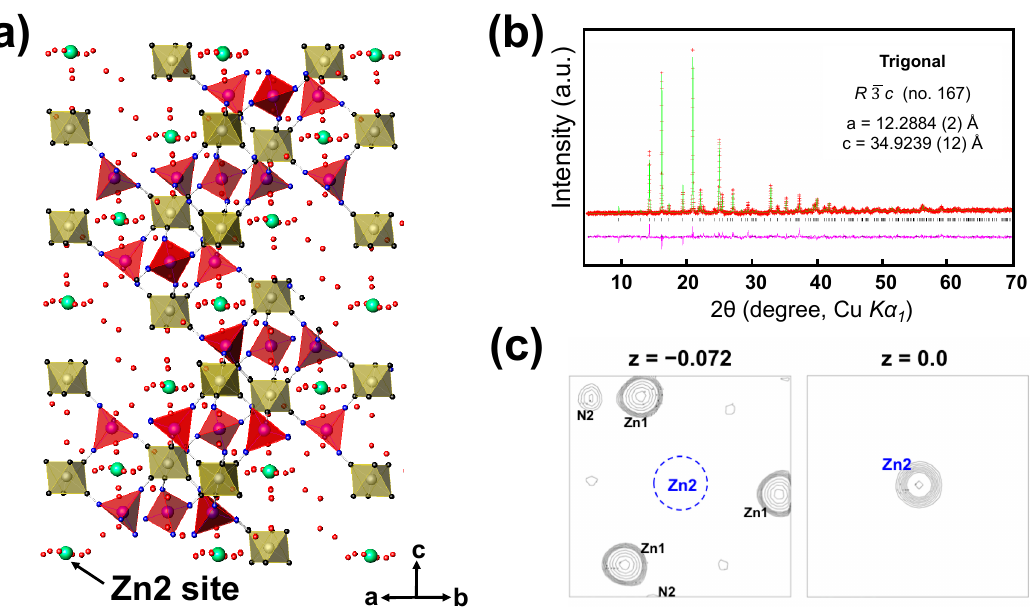
Figure 5. ( a ) The crystal structure of Zn 0.72 ZPB, with FeC 6 octahedra (yellow), ZnN 4 tetrahedra (red), and inserted Zn2 atoms (green). ( b ) The powder X-ray Rietveld refinement profile for Zn 0.72 ZPB, recorded at 25 °C (Red points: experimental data; green line: calculated data; pink line: difference; and bars: Bragg positions). ( c ) (001) sections of observed Fourier map at z = − 0.072 (left) and difference Fourier maps at z = 0.0 (right) for the Zn 0.72 ZPB phase at the refinement stage prior to the location of Zn2 atoms. The map width is 10 Å, and the center of the left map is at (0, 0, − 0.072). The contour levels are adjusted unequally for clarity. Zn2 is identified from the right plane that is above the left plane by 2.51 Å ( ∆ z = 0.072). The minimum and maximum contour levels are ( a ) 2.71 and 20.1 e/Å 3 , and ( b ) 2.71 and 14.5 e/Å 3 .